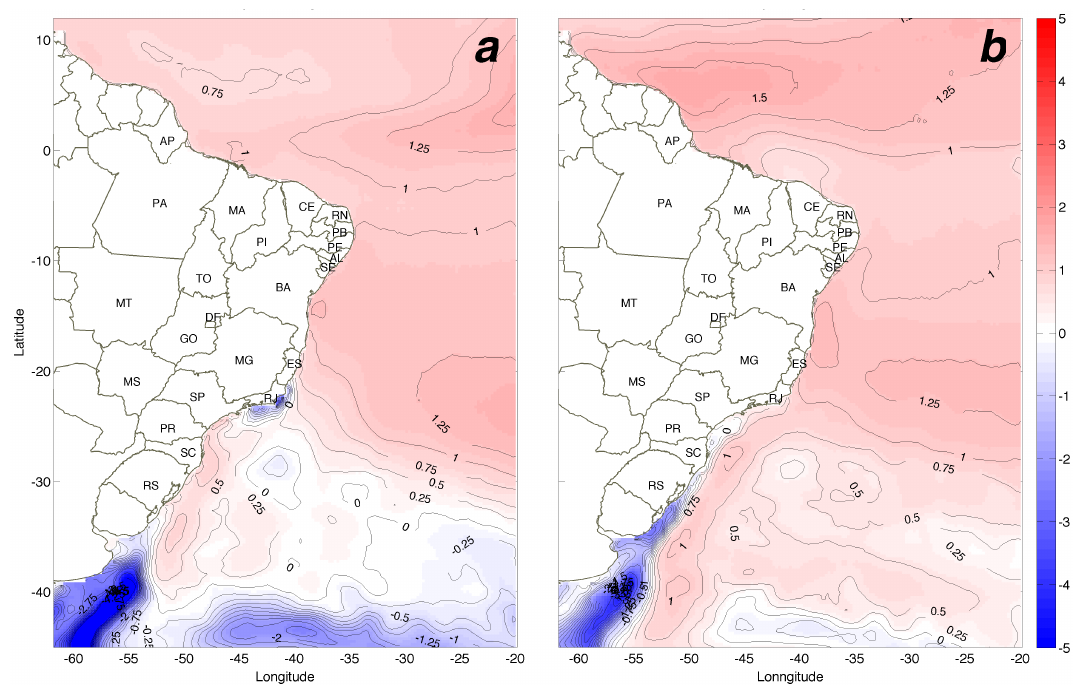
Figure 4. Surface layer dimensionless stability function ψ for ( a ) January and ( b ) July. ψ is computed from thermodynamic properties derived from OAFLUX, NCEP and BSW datasets (1987–2014). Intervals are: stable atmospheric conditions ( ψ < − 2.5), slightly stable ( − 2.5 ≤ ψ < 0), neutral ( ψ ∼ 0) and unstable conditions ( ψ >